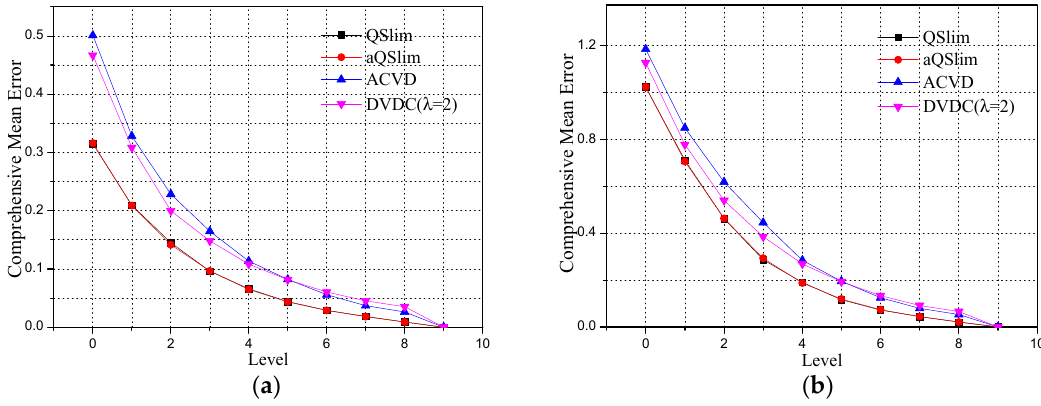
(lines 6, 7), and users are then able to identify the optimal means of extracting planar surfaces and whether to extract and measure the error of urban frameworks (line 8). Lines 9–20 are responsible for obtaining the indexes correlated to the classification of detailed and planar surfaces. The indexes for urban frameworks are implemented in lines 21–24.